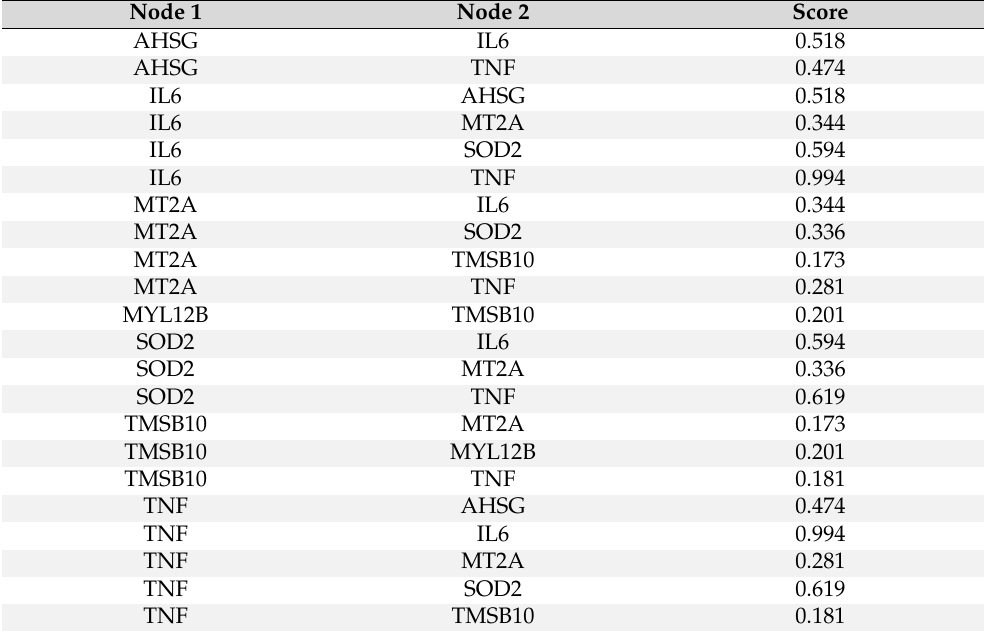
Table 5. Network interaction